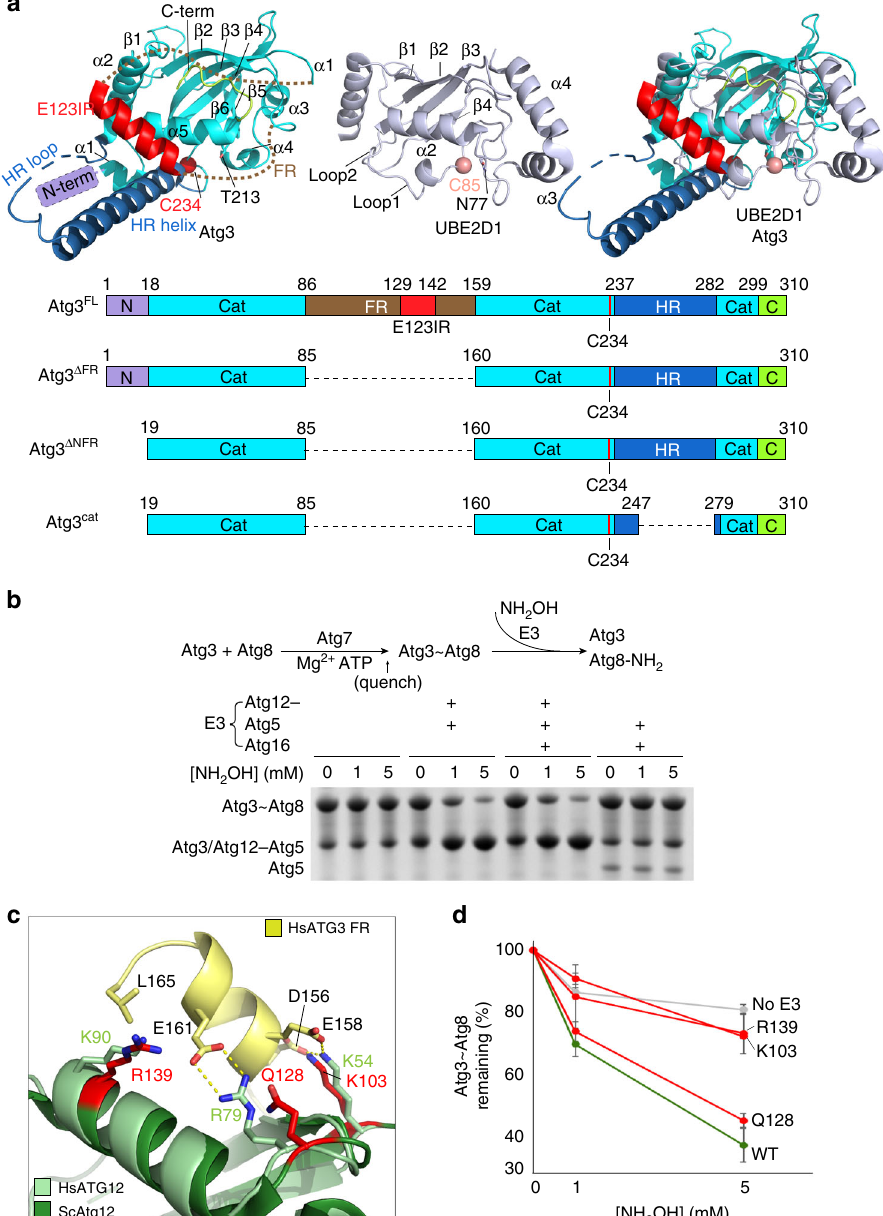
Fig. 1 The Atg12 – Atg5 module within the autophagy E3 activates intrinsic reactivity of the Atg3~Atg8 intermediate. a Structures of yeast Atg3 (left, PDB 2DYT), a ubiquitin E2 (middle, UBE2D1, PDB 4AP4), and their superimposition (right). Atg3 unique elements are indicated by colors shown in schematics of Atg3 constructs used in this study (below). b Intrinsic reactivity of Atg3~Atg8 intermediate monitored by pulse-chase discharge to NH 2 OH in presence of indicated E3 variant. c Close-up of structural superimposition of yeast Atg12 – Atg5-Atg16 (PDB 3W1S) and corresponding human complex with ATG3 FR (PDB 4NAW). Residues from yeast Atg12 corresponding to the human ATG3 FR -binding site are shown as red sticks. d Effects of mutations in minimal yeast E3 (Atg12 – Atg5) on stimulating Atg3~Atg8 discharge, monitored by quanti fi cation of Atg3~Atg8 remaining after 2.5 min in pulse-chase assays using the scheme as in ( b ), as a function of NH 2 OH concentration. (Error bar: STDEV, N = 3) Representative gel is shown in Supplemental Fig. 1b; all points are shown in Source Data